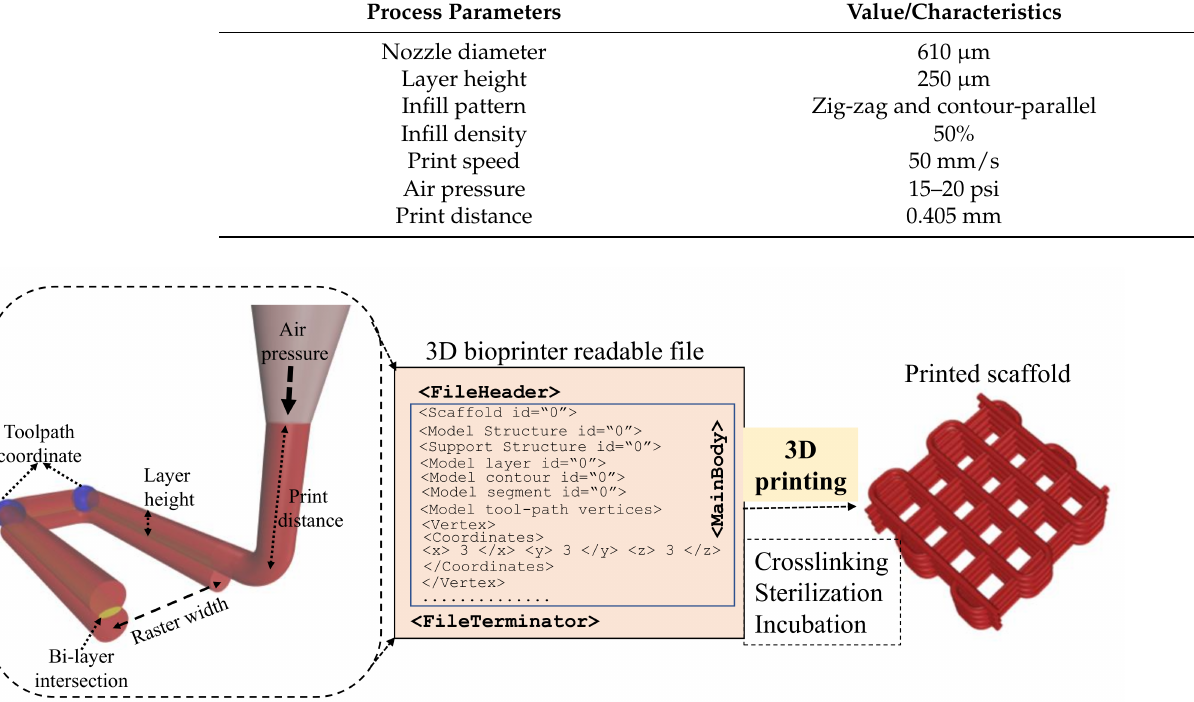
Figure 2. Schematic representation of 3D bioprinting